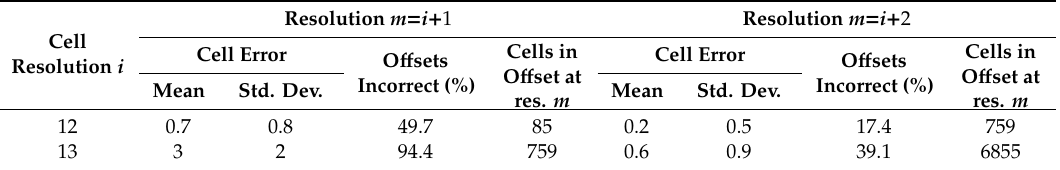
Table 3. Error statistics for modelling a mobile 30 m o ff set region at coarse resolutions using the proposed